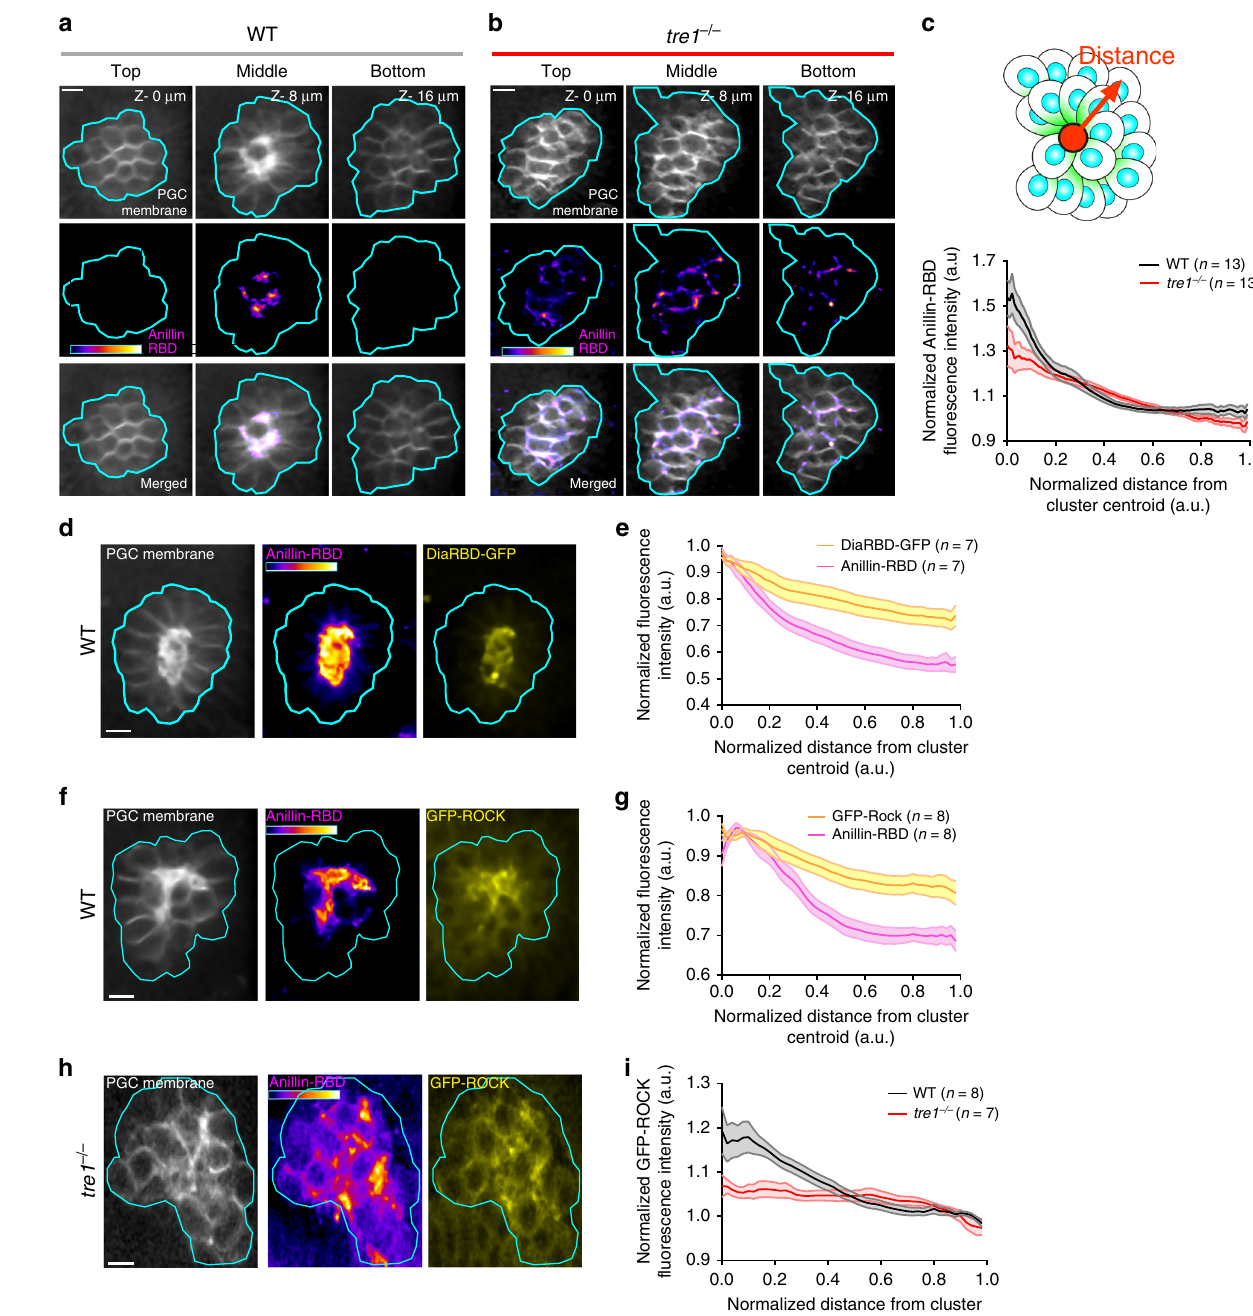
normalized to max intensity. Shaded region represents SEM. h Two photon imaging of a single Z slice from a representative tre1 − / − PGC cluster